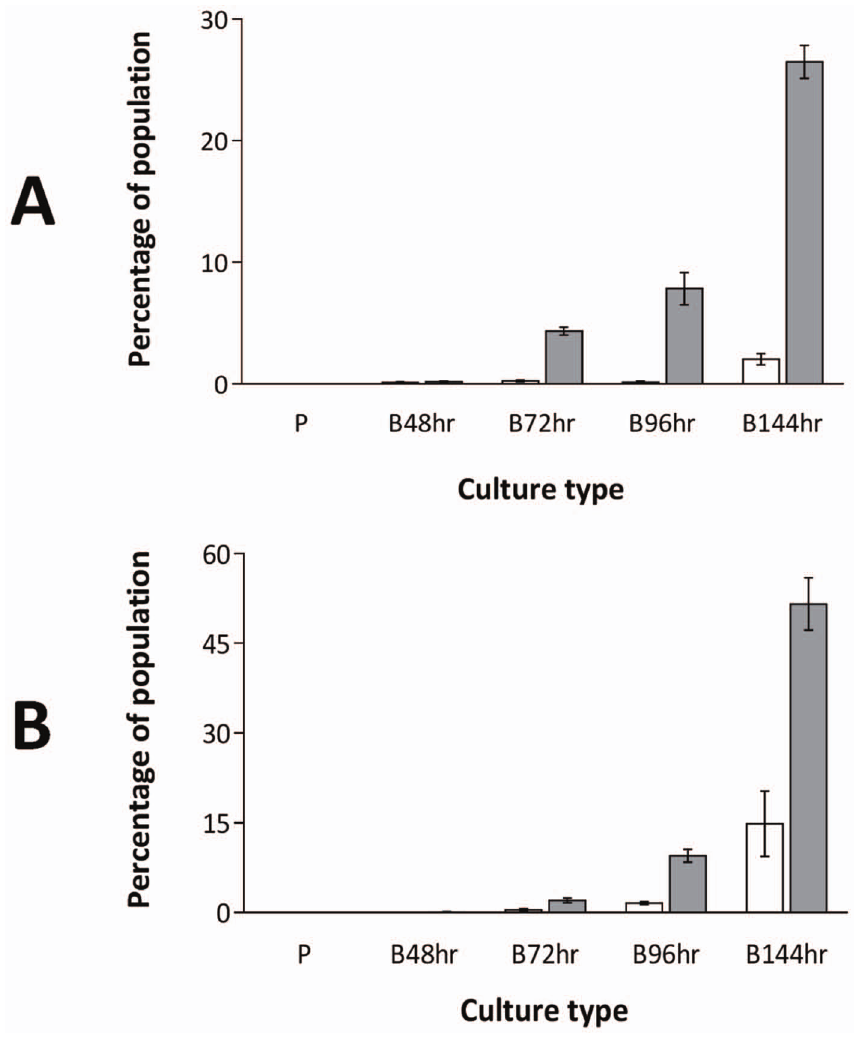
Figure 2. Quantification of morphological variants of S.aureus SH1000 arising in planktonic cultures (denoted by ‘P’) and CDS biofilms (denoted by ‘B’). (A) WVs and (B) LPVs (white and grey bars indicate the proportion of variants present in the adherent and nonadherent phase, respectively). Data are the means of three experimental replicates, and error bars indicate standard error.